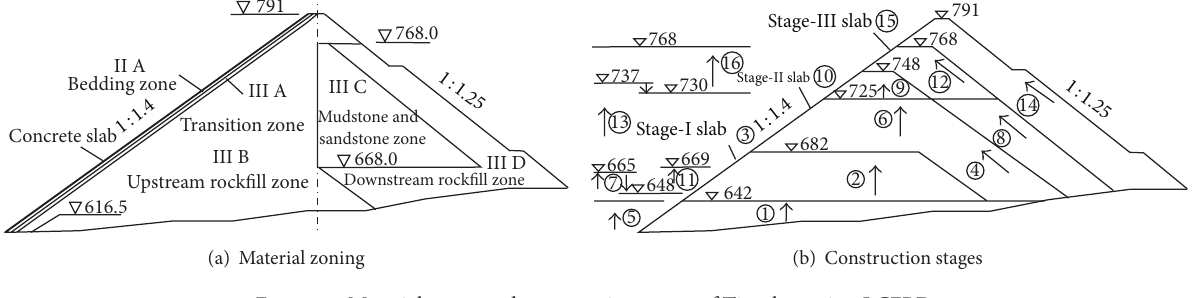
Figure 5: Material zones and construction stages of Tianshengqiao-I CFRD. Table 1: Design parameters of dam materials.